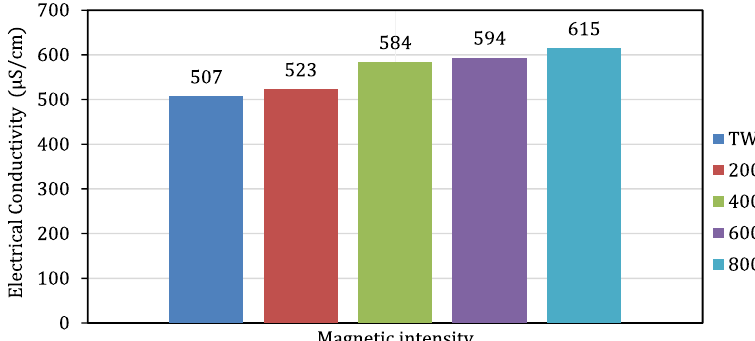
Figure 7: Variation in EC with the increase in MF